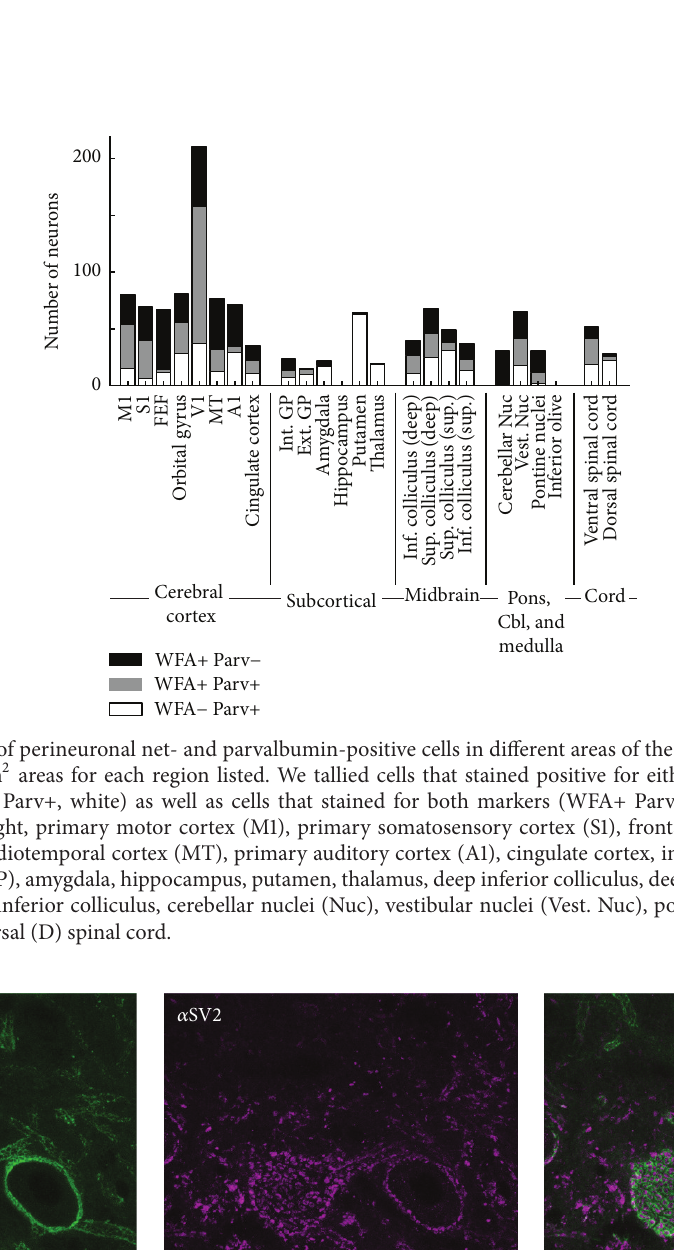
Figure 9: Perineuronal nets surround synapses in cerebellar nuclear neurons. WFA-positive PNNs (green) ensheath the soma and proximal dendrites of neurons in the cerebellar nucleus (pink). They form openings around synapses, labeled with an antibody to synaptic marker SV2 (pink). 𝑍 -projection of 10um confocal stack. Scale bar = 20 𝜇